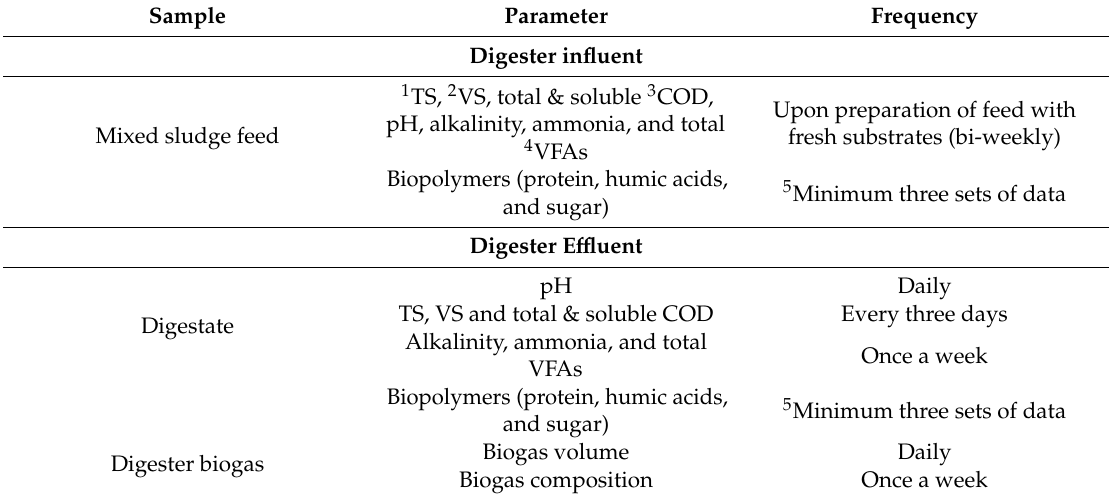
Table 3. Characterization of conventional parameters and frequency of analysis a